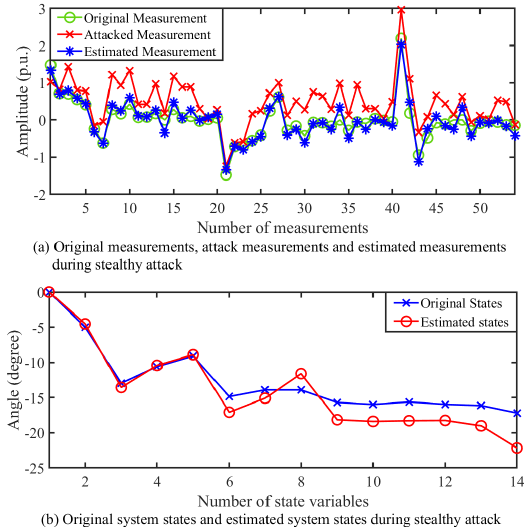
Figure 4. Estimated measurements and system states during cyber